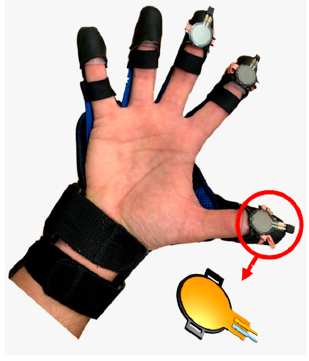
Figure 2 . Force sensors positioned at the fingertips of Gloreha Sensor Glove. Figure 2. Force sensors positioned at the fingertips of Gloreha Sensor Glove.